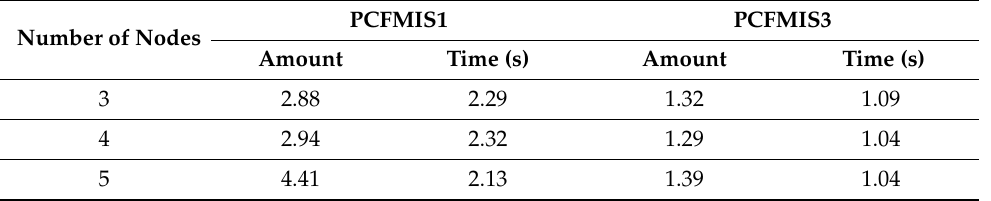
Table 4. The amount ratio and time ratio in different Gnum groups of D50. PCFMIS1 Number of Nodes